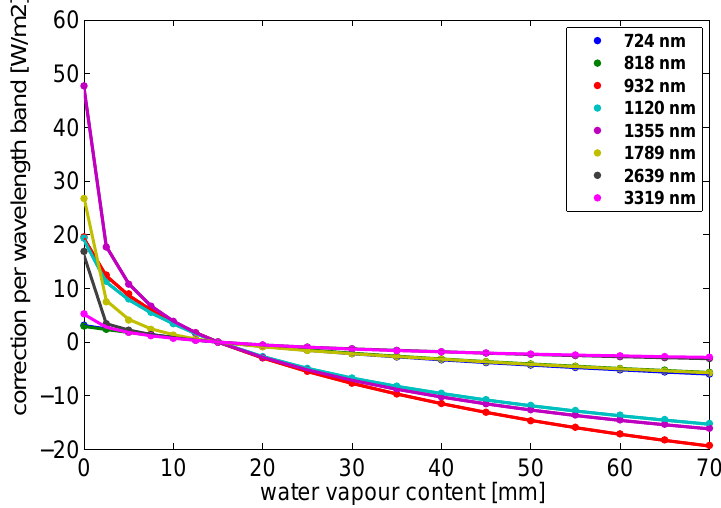
Figure 3. Differences between I H 2 O (dots) and by use of the correction formula (lines, Equation (4)) for eight Kato wavelength bands and the solar zenith angle of 20 ◦